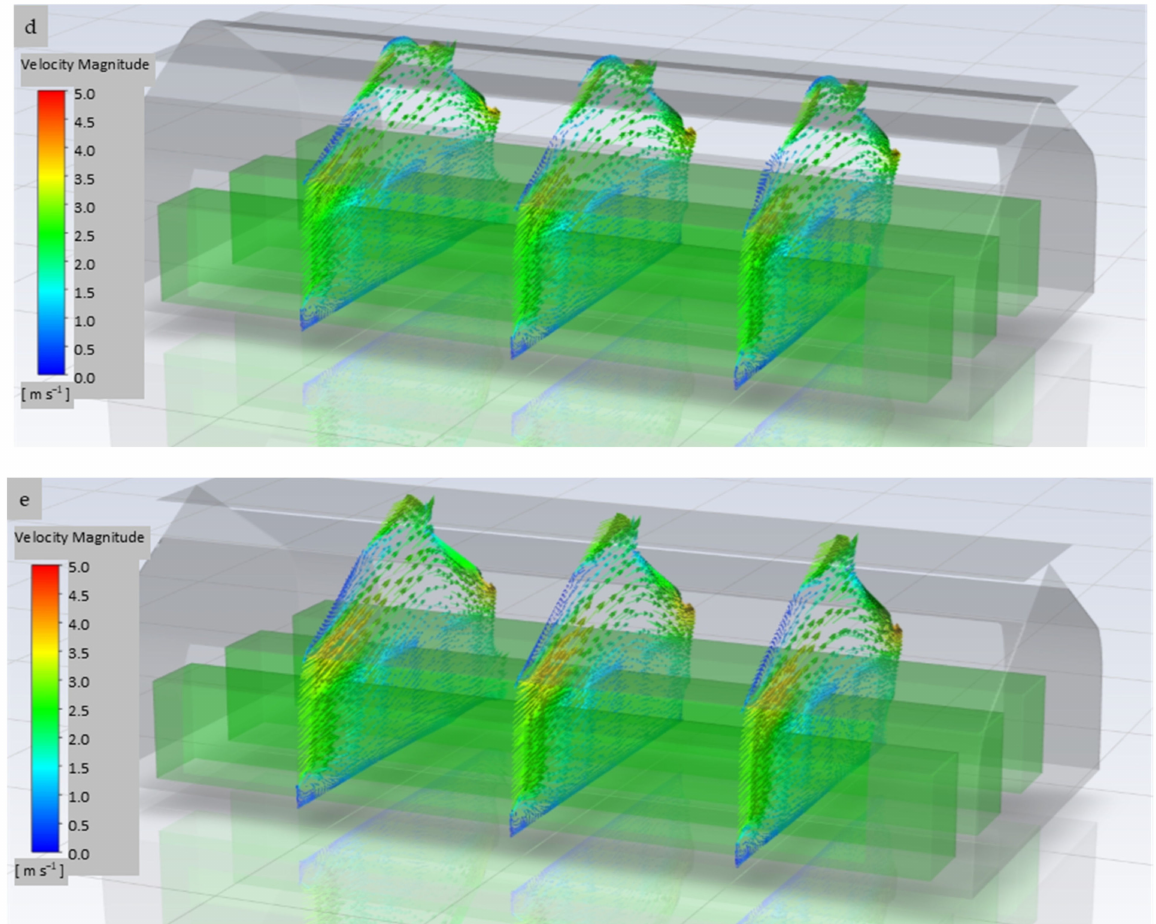
Figure 9. Simulated velocity vectors at three representative cross-sections within high tunnels outfitted with different roof vent designs: ( a ) roll-up side vents only; ( b ) added windward roof vent; ( c ) added leeward roof vent; ( d ) added windward and leeward roof vents; and ( e ) added ridge vents.